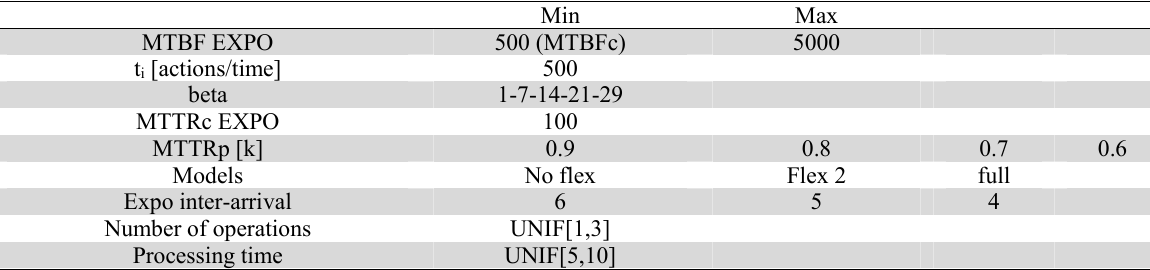
Simulation data